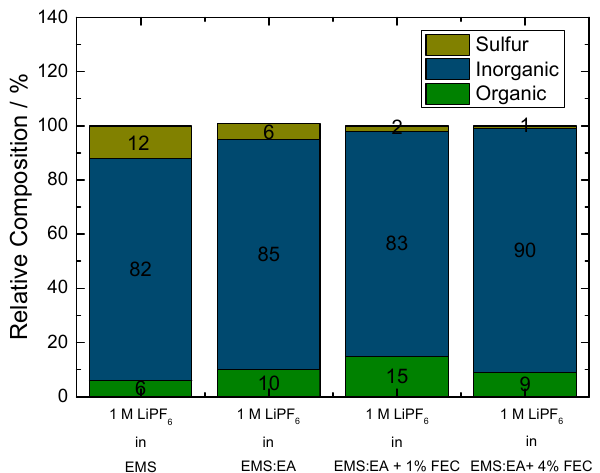
Figure 6. Relative composition of sulfur content, organic and inorganic part of the SEI.